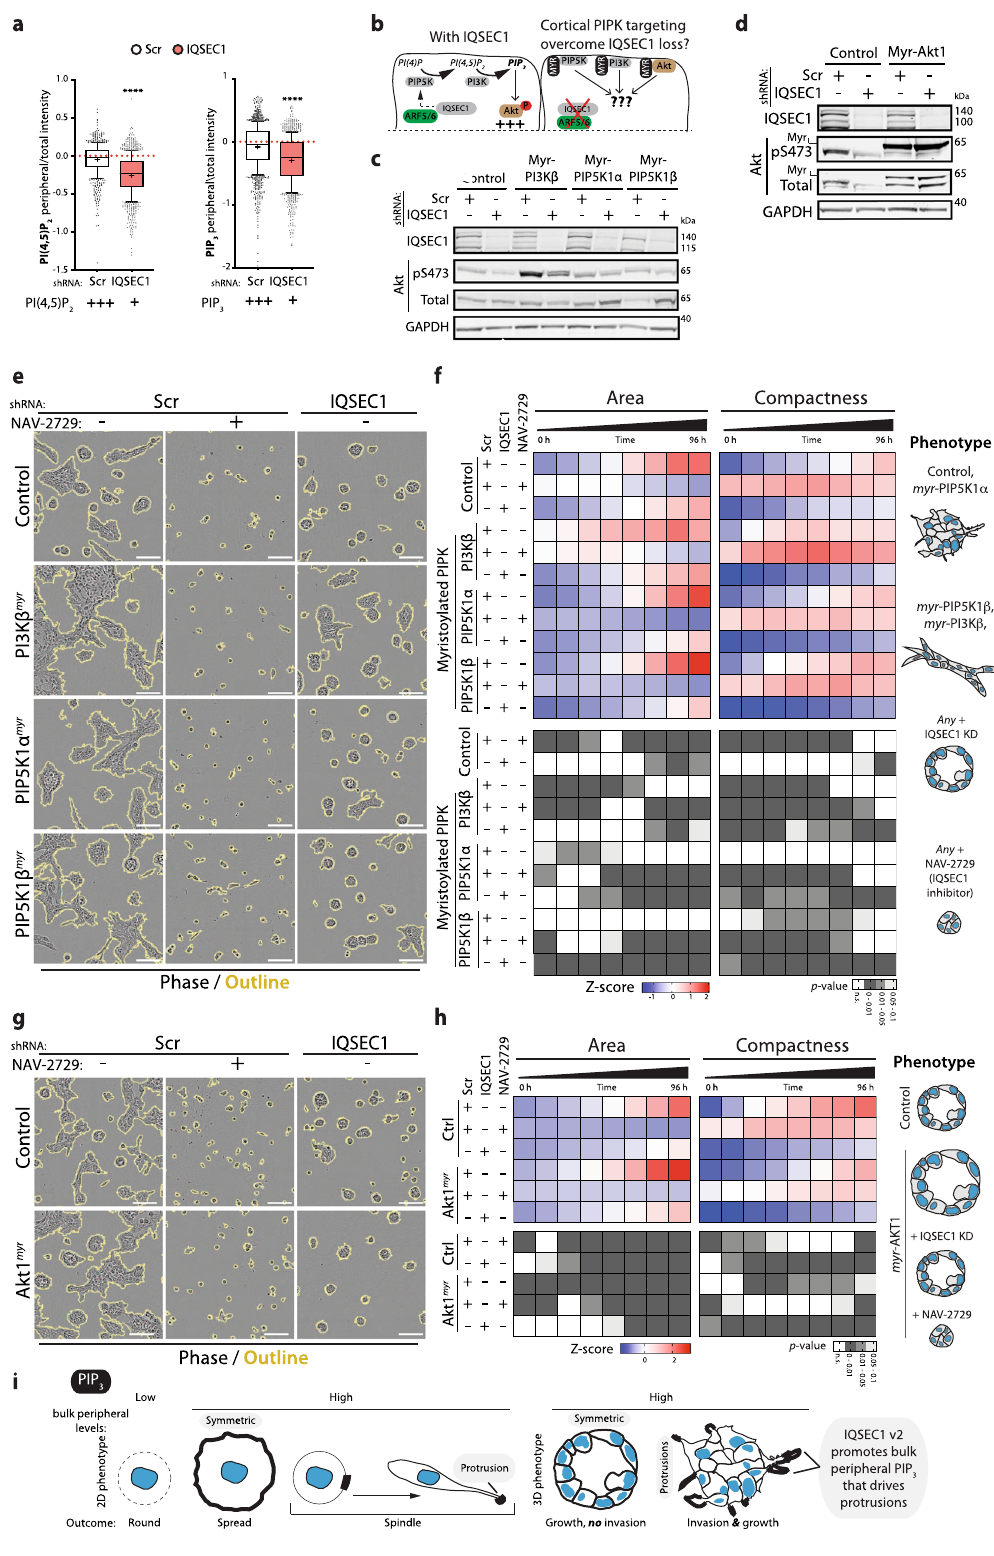
clear PI3K-AKT signature was associated with high IQSEC1 levels across ten tumour types (Fig. 8t). Together, these data indicate a role for tumour-associated isoform switching to IQSEC1 v2 to promote PI3K-AKT signalling and metastasis across cancer types, resulting in treatment resistance and a robust decrease in patient